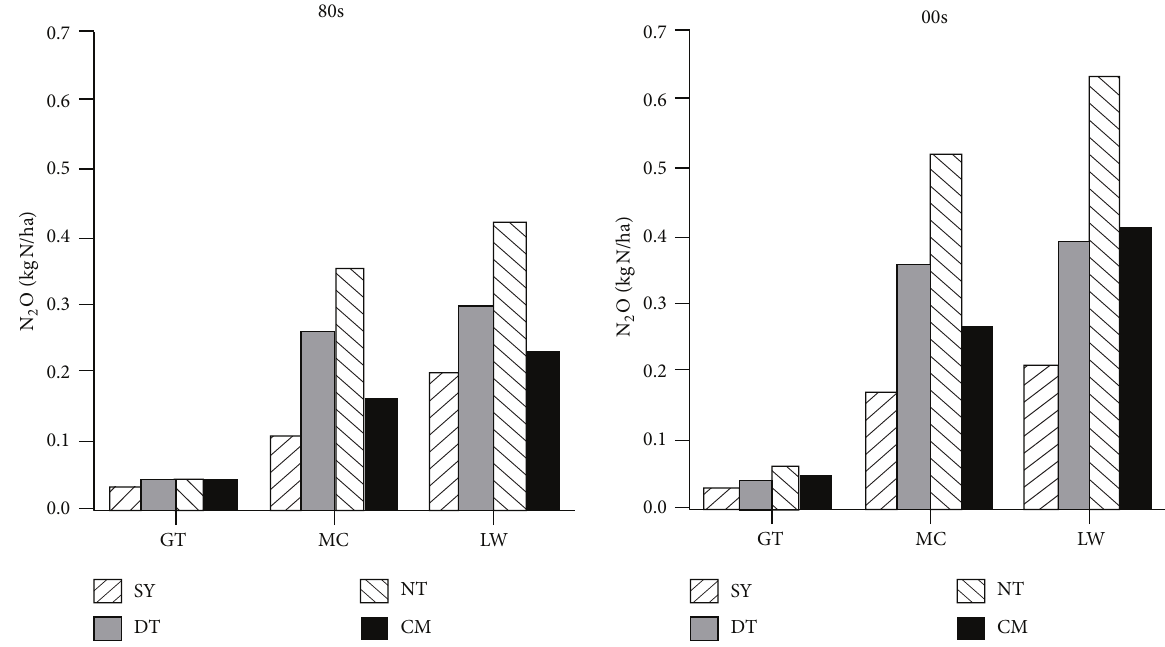
Figure 3: Comparison of N 2 O emission flux of different beach in 80s and 00s (SY, DT, NT, and CM represent Sheyang, Dongtai, Nantong, and Chongming, resp.; GT, MC, and LW represent bare beach, Spartina beach, and Phragmites beach,